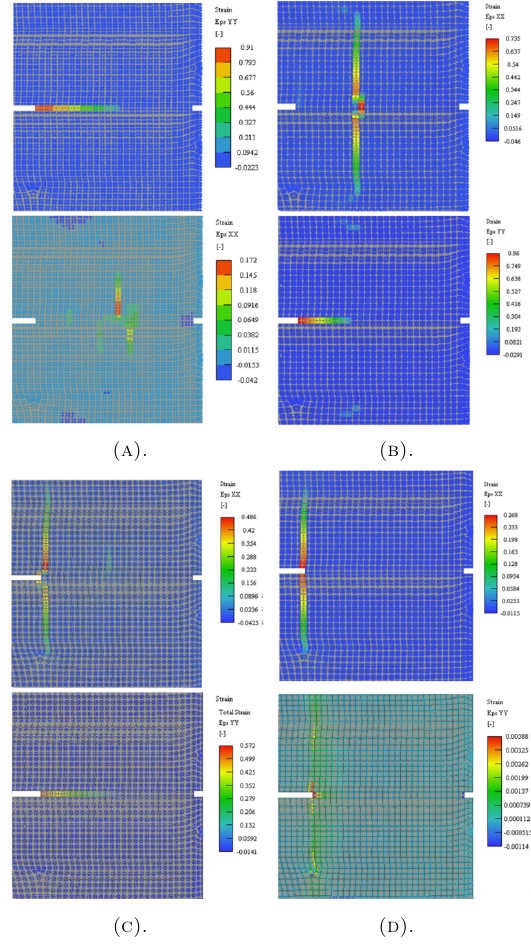
Figure 17. Distributions of normal strains ε ε yy obtained from the CT test simulations with differ- ent pre-stress levels: (A) pre-stress 3 . 3 MPa (state at U y = 7 . 0 mm), (B) pre-stress 3 . 0 MPa (state at U y = 9 . 0 mm), (C) pre-stress 2 . 7 MPa (state at U y = 7 . 0 mm), and (D) pre-stress 1 . 0 MPa (state at 1 . 5